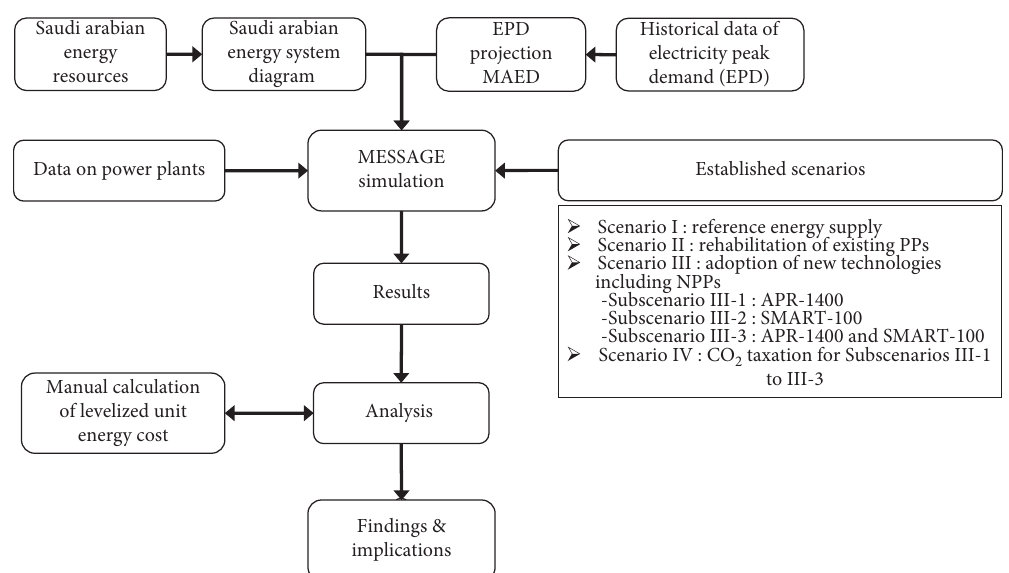
Figure 2: Overall approach and procedure for long-term electric power strategy of Saudi Arabia adopted in this